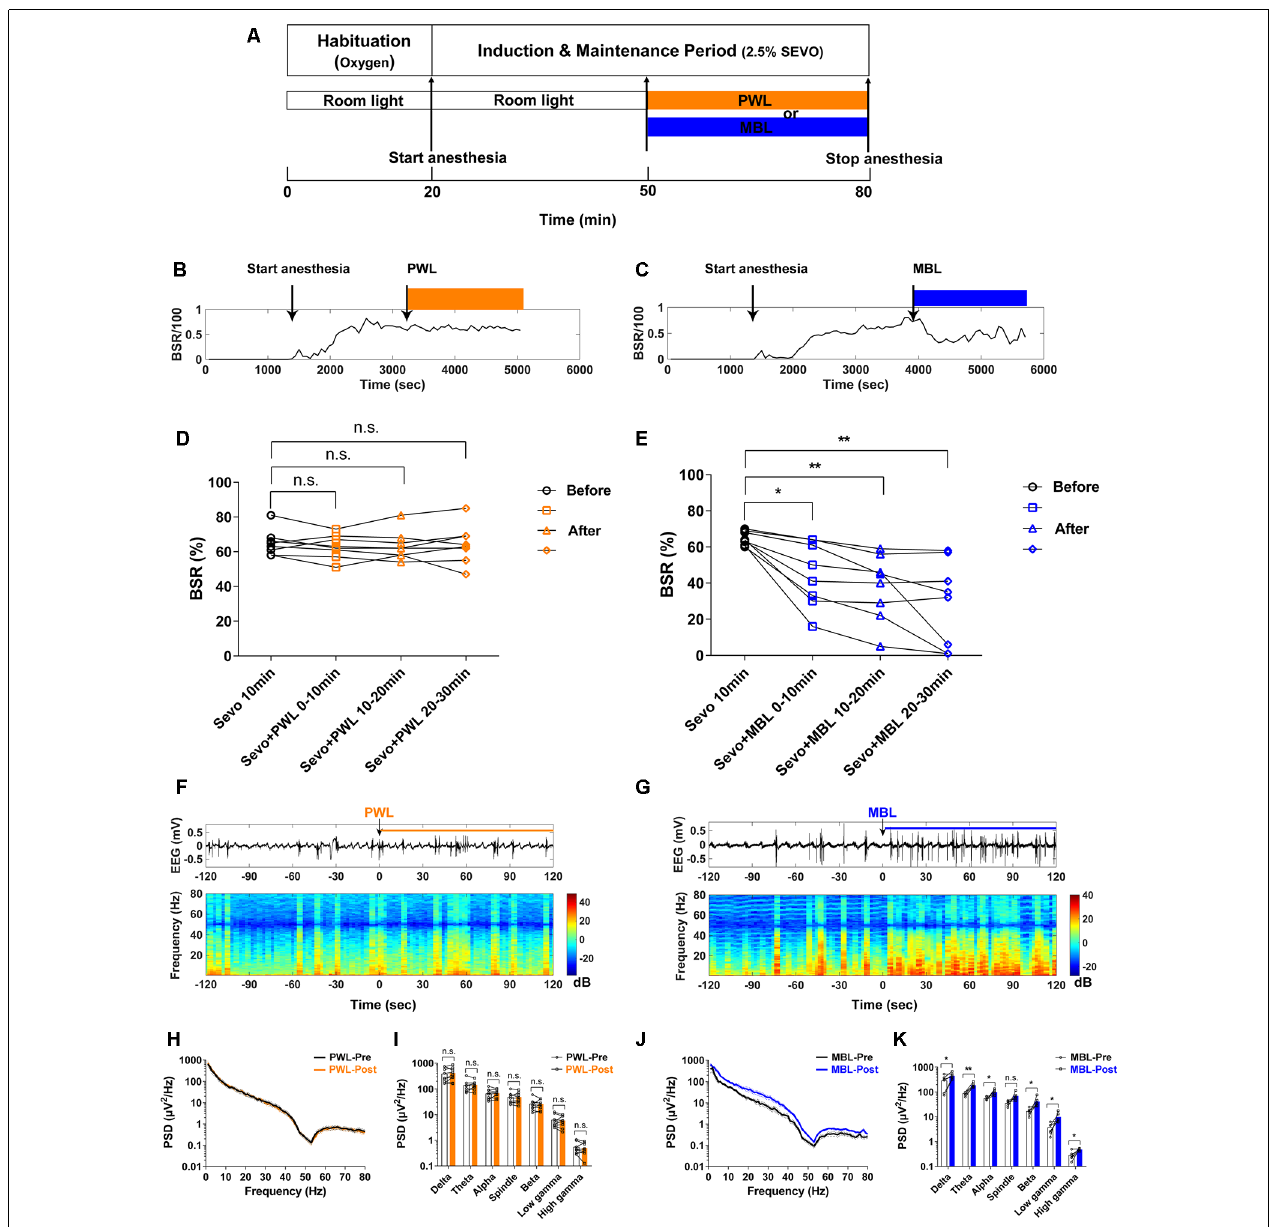
FIGURE 2 | MBL decreased the burst suppression ratio (BSR) during continuous inhalation of 2.5% sevoflurane. (A) Timeline for light conditions administered in the burst suppression period during continuous inhalation of 2.5% sevoflurane. (B,C) Typical examples of the BSR response under sevoflurane anesthesia in a mouse administered PWL (B) or MBL (C) . The orange and blue boxes indicate the duration of light exposure. (D,E) Effect of PWL (D) and MBL (E) on electroencephalogram BSR during continuous inhalation of 2.5% sevoflurane. Mice treated with MBL showed a significant 31% decrease (*) in the BSR during the first 10 min post-MBL, a 42% decrease (**) during the second 10 min post-MBL, and a 55% decrease (**) during the last 10 min post-MBL compared to the pre-MBL 10 min (* p < 0.05, ** p < 0.01 compared with pre-MBL 10 min, n = 8, RM one-way ANOVA, and Tukey’s multiple comparisons test with the Greenhouse-Geisser correction, F (2.007,14.05) = 16.18). However, PWL-treated animals showed no significant difference in the BSR compared to pre-PWL (n.s. = not significant, compared with pre-PWL 10 min, n = 8, RM one-way ANOVA, and Tukey’s multiple comparisons test with the Greenhouse-Geisser correction, F (2.540,17.78) = 0.5143). (F,G) Representative electroencephalogram traces (upper) and electroencephalogram power spectrogram (lower) in a mouse administered PWL (F) or MBL (G) . Time 0 indicates the beginning of light stimulation during continuous sevoflurane anesthesia. The orange and blue lines indicate the 120 s intervals used for power spectral density comparisons. (H) Grouped PSD computed from 2 min before PWL (black) and 2 min after PWL (orange). (I) PWL-treated animals showed no statistically significant difference in electroencephalogram power compared to pre-PWL (n.s. = not significant, compared with pre-PWL, n = 9, and paired Student’s t -tests). (J) Grouped PSD computed from 2 min before MBL (black) and 2 min after MBL (blue). (K) MBL-treated animals increased electroencephalogram power in all of the frequency bands except for the spindle band compared to pre-MBL (* p < 0.05, ** p < 0.01 compared with pre-MBL, n.s. = not significant, n = 6, and paired Student’s t -tests). PWL, polychromatic white light; MBL, monochromatic blue